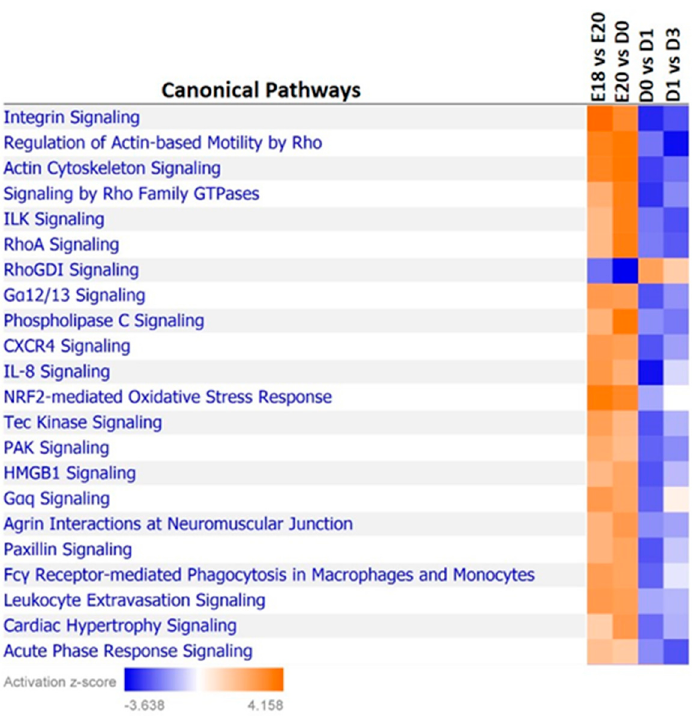
Figure 1. Comparison of canonical pathway activation z-scores in the adipose tissue of pre- and post-hatch chicks. Ingenuity Pathway Analysis was utilized to compare the gene expression signatures of canonical pathways identified in the transcriptome profiling of the adipose tissue (white leghorn) in late stage embryos and early post-hatch chicks. Many canonical pathways have a defined demarcation in their predicted activation/inhibition (z-score) at the time of hatch (D0).